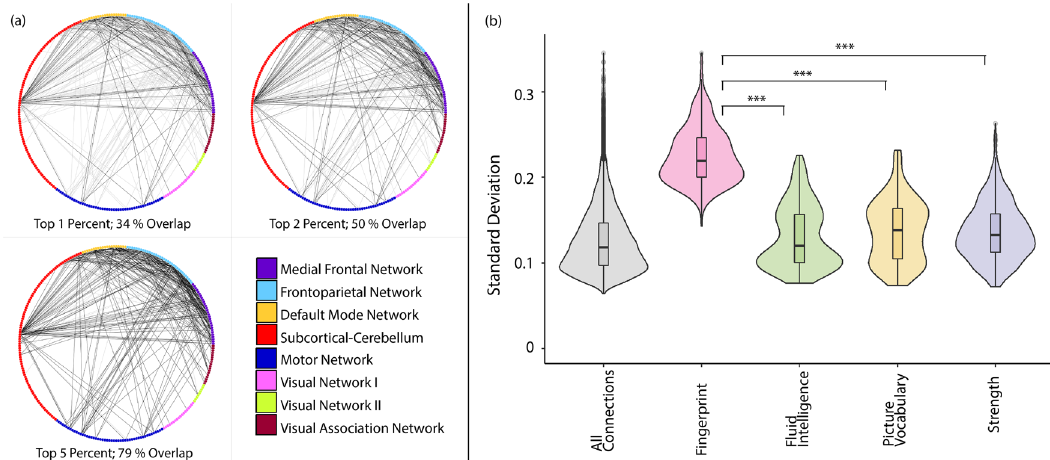
Fig. 4 Overlap of discriminatory edges and high-variability edges. a Black lines designate overlapping edges between the top one, two or fi ve percent of discriminatory edges and high-variability edges. Grey lines depict non-overlapping discriminatory edges. b Shows the distribution of edge standard deviation across participants. In the boxplot, the middle line signi fi es the median, the lower and upper hinges correspond to the fi rst and third quartiles and the upper and lower whisker represent 1.5 times the respective interquartile ranges. All points outside of whiskers are outliers. *** p < 0.001,